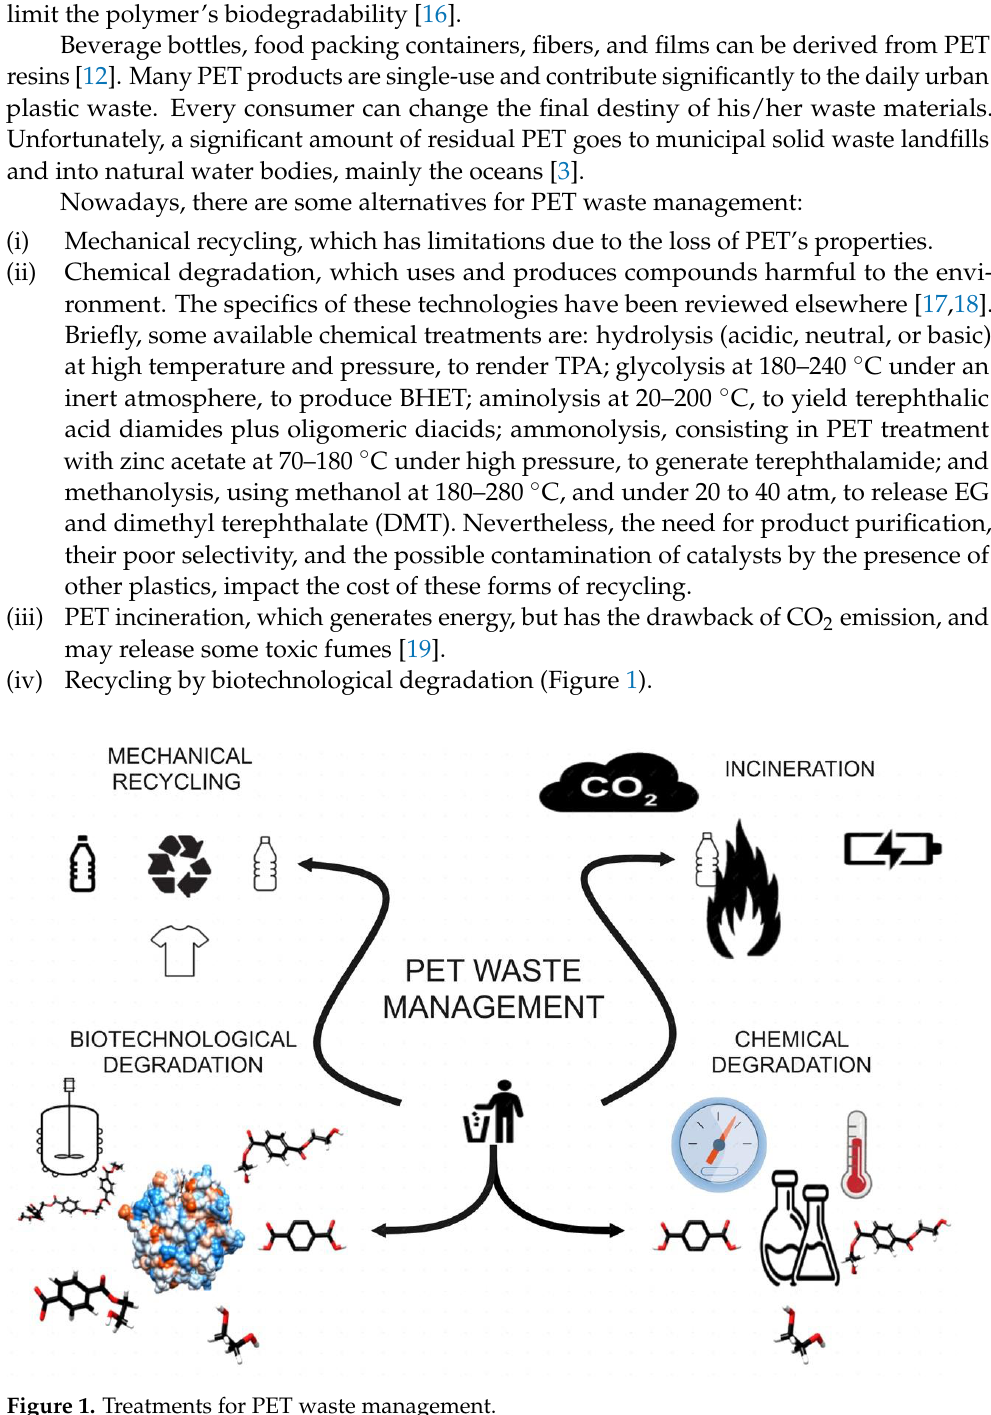
Figure 1. Treatments for PET waste management.